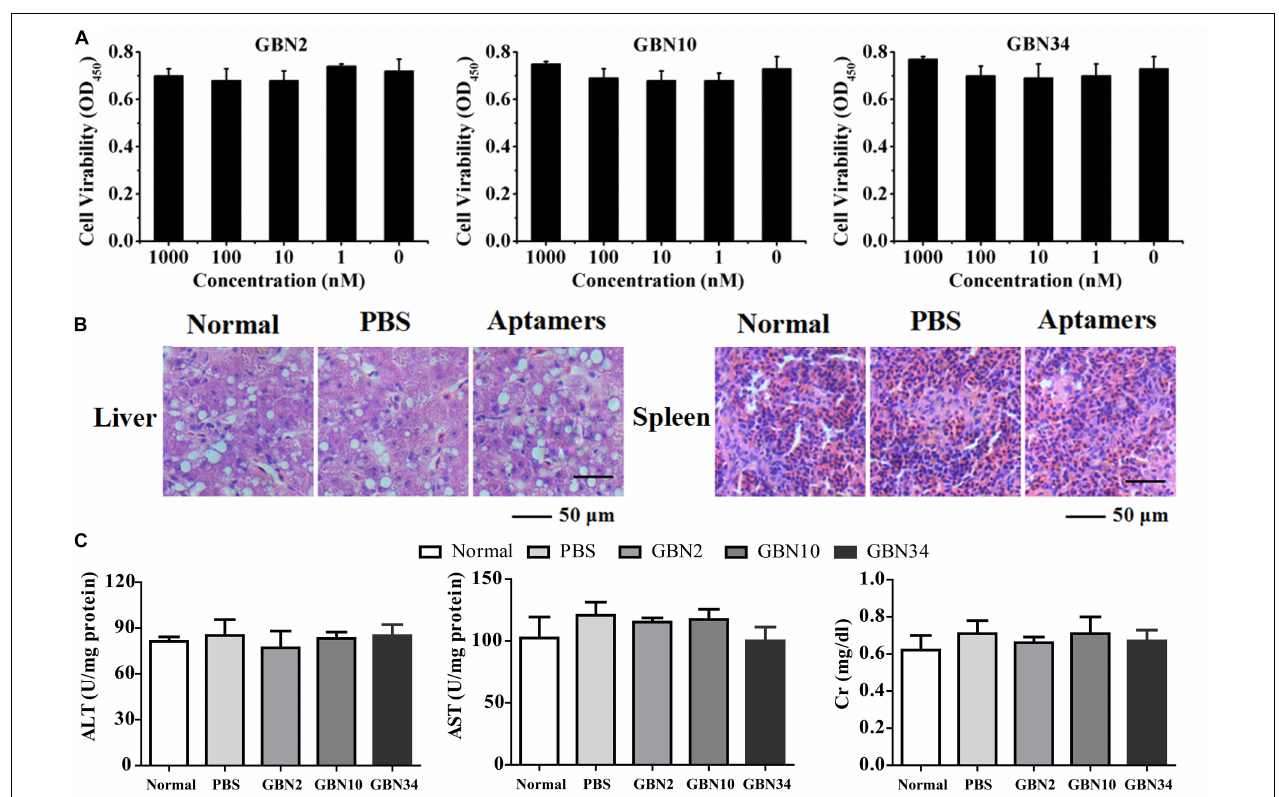
FIGURE 3 | Cytotoxicity and histological toxicity assays. (A) Cytotoxicity of each aptamer serially diluted to a concentration gradient (0, 1, 10, 100, or 1000 nM) was measured with a colorimetric assay based on the cell proliferation reagent WST-1. All three aptamers showed no significant cytotoxic effects on GB cells, even at high concentrations of 1000 nM. Results of three independent experiments were averaged. (B) Histological toxicity analysis of GBN34 also showed no obvious pathological changes in the liver or spleen tissues of the tested fish. (C) Analysis of activity of ALT, AST of liver, and serum Cr. (** P < 0.01; * P <